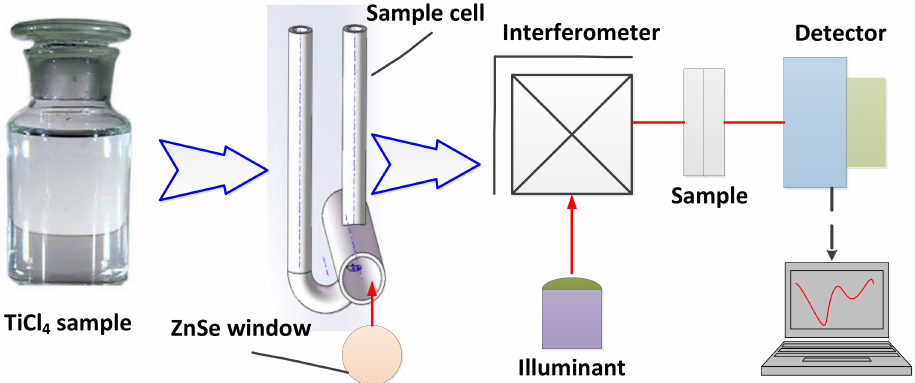
Figure 1. Schematic illustration of the chloroacetyl chloride (CAC) measurement equipment.